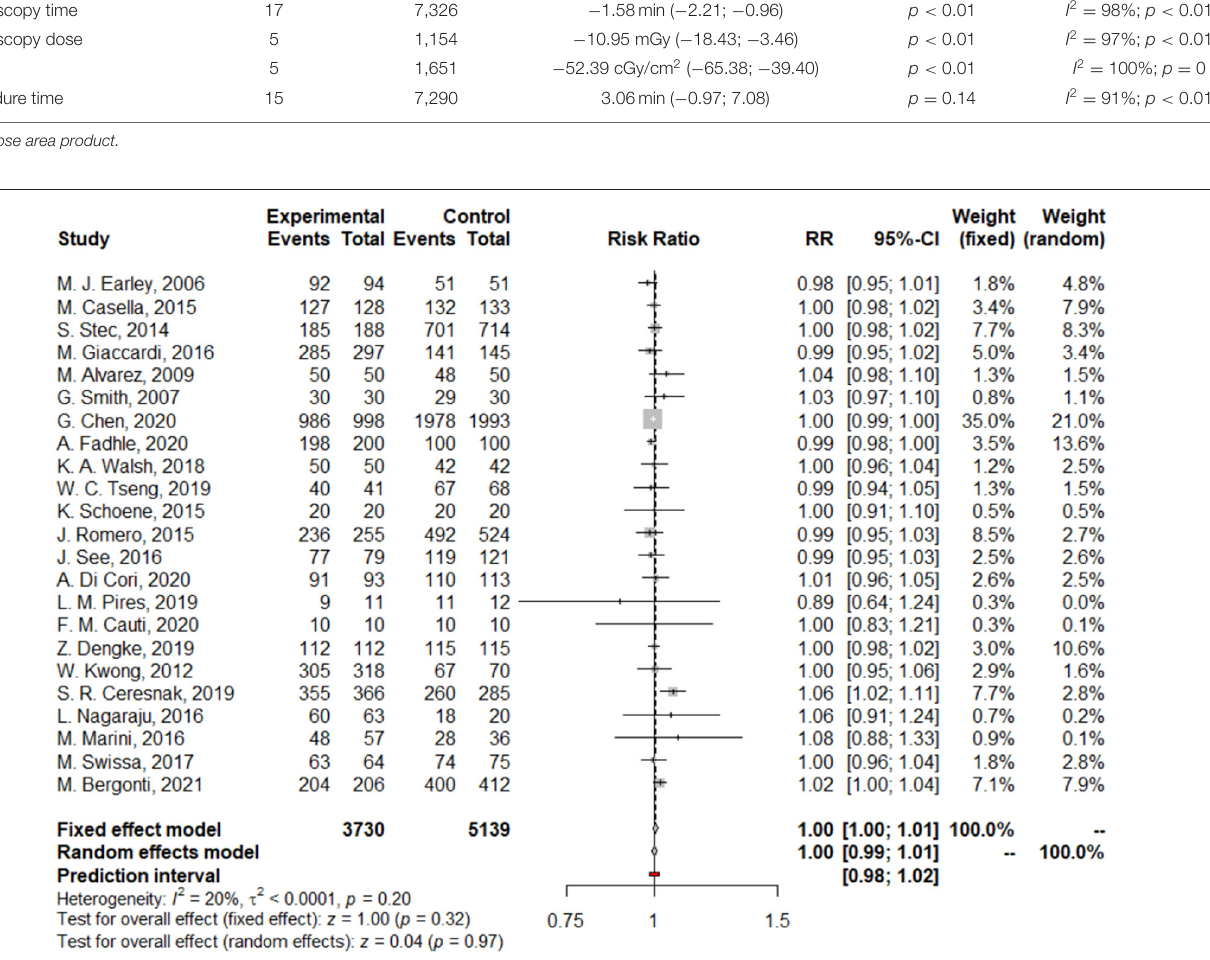
FIGURE 2 | Forest plots of acute success